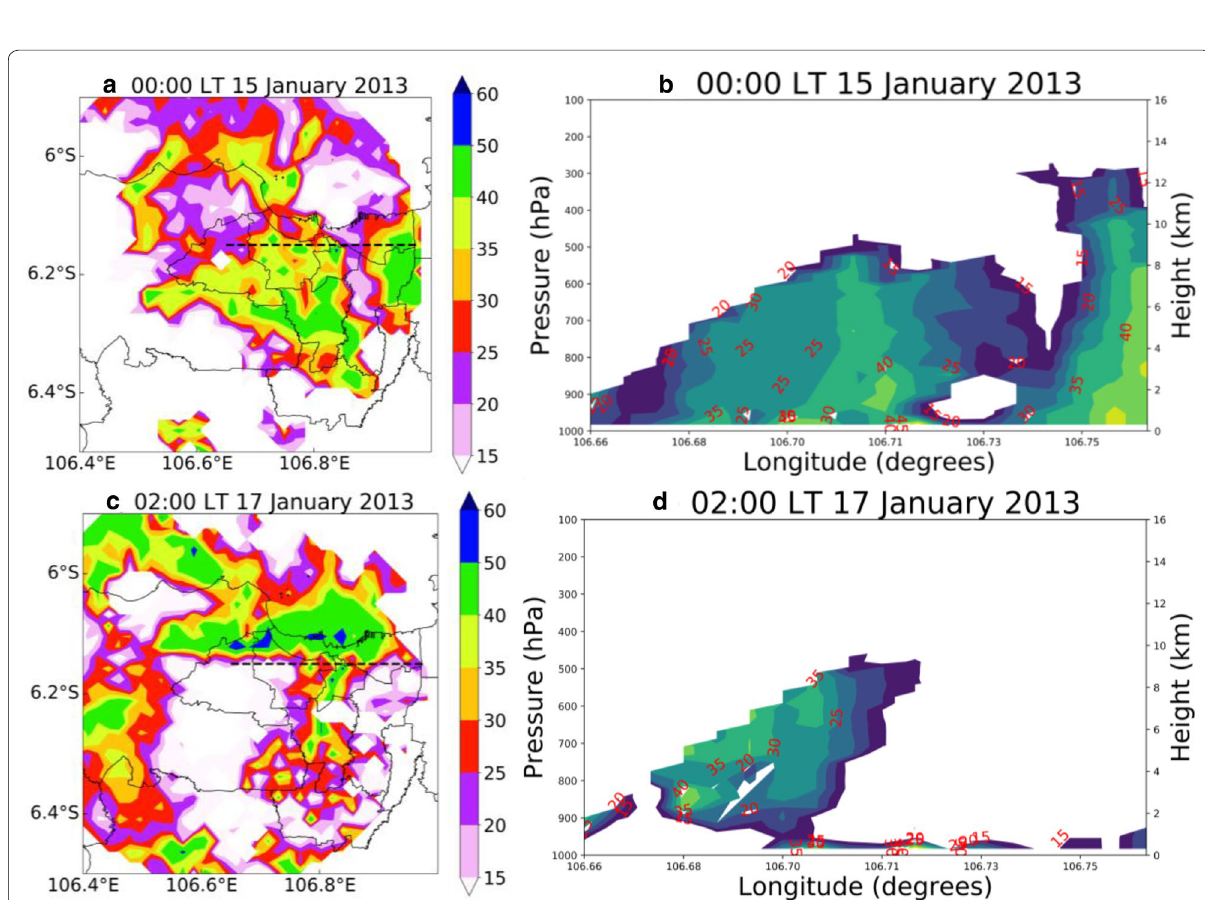
Fig. 7 Horizontal section of radar reflectivity (dBZ, color shading) at a height of 2 km observed by Cengkareng radar at a 00:00 LT 15 January 2013 and c 02:00 LT 17 January 2013 based on Fig. 2. The black dashed line denotes the vertical section of longitude 106.65°E to 106.96°E and